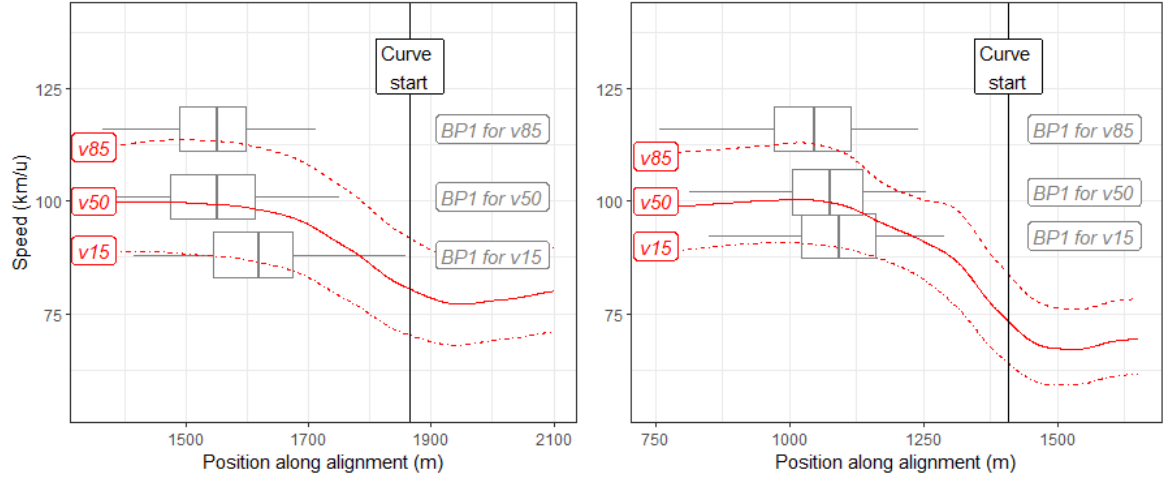
Figure 4. Two examples showing the 15 th , 50 th and 85 th speed profile, and their respective distributions of positions of BP1 and the position of curve start along the alignment. The values for the v85 and positions of the breakpoints are plotted in Figure 5, shown in relation to the horizontal radius of the curve. The grey points represent all the 153 curves in the dataset, the black points represent the specific group used. The used groups show a lesser variability than the entire set, which is to be